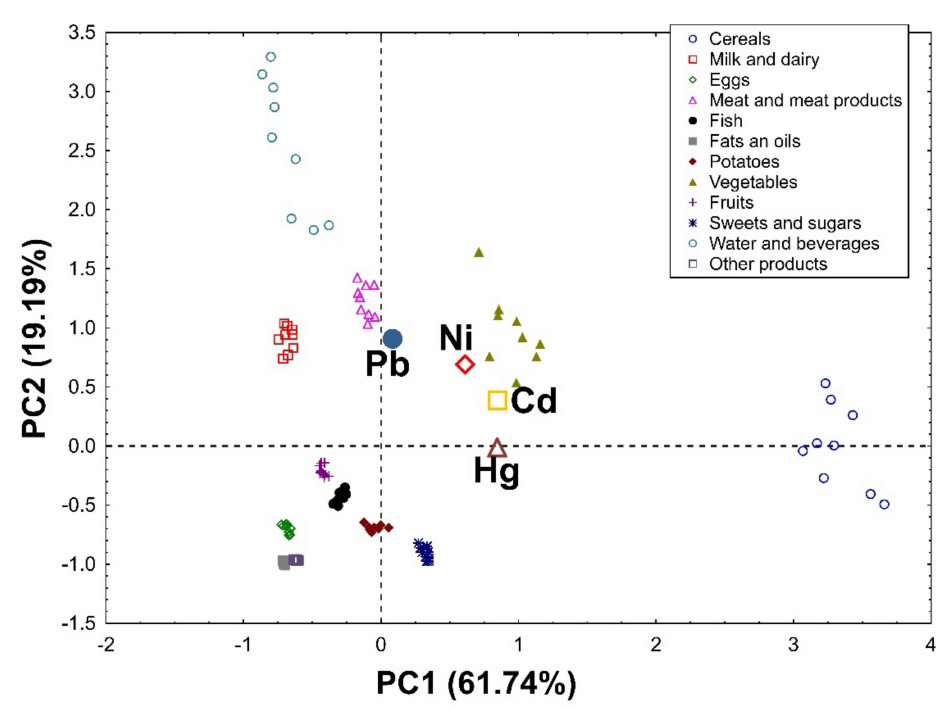
Figure 2. PCA biplot showing loadings (for heavy metals) and scores (for products) of the first two principal components of PCA in the group of men, explaining together 80.93% of the variability in the obtained dataset (61.74% and 19.19% in PC1 and PC2,